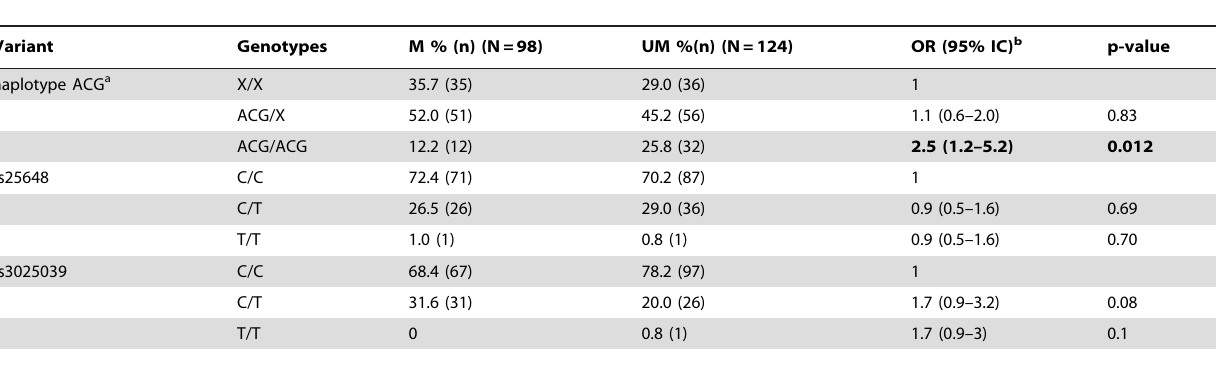
Table 4. Distribution of VEGF genotypes in B-CLL groups with different mutational status of the IgV H genes.